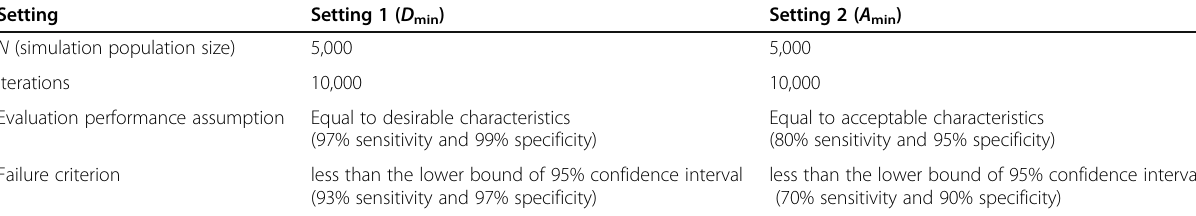
Table 1 Description of the simulation setting assumptions made based on the Target Product Profiles (TPPs), where D min corresponds to the scenario where the minimum number of cases were correctly detected to satisfy the desirable TPP and A min corresponds to the scenario where the minimum number of cases were correctly detected to satisfy the acceptable